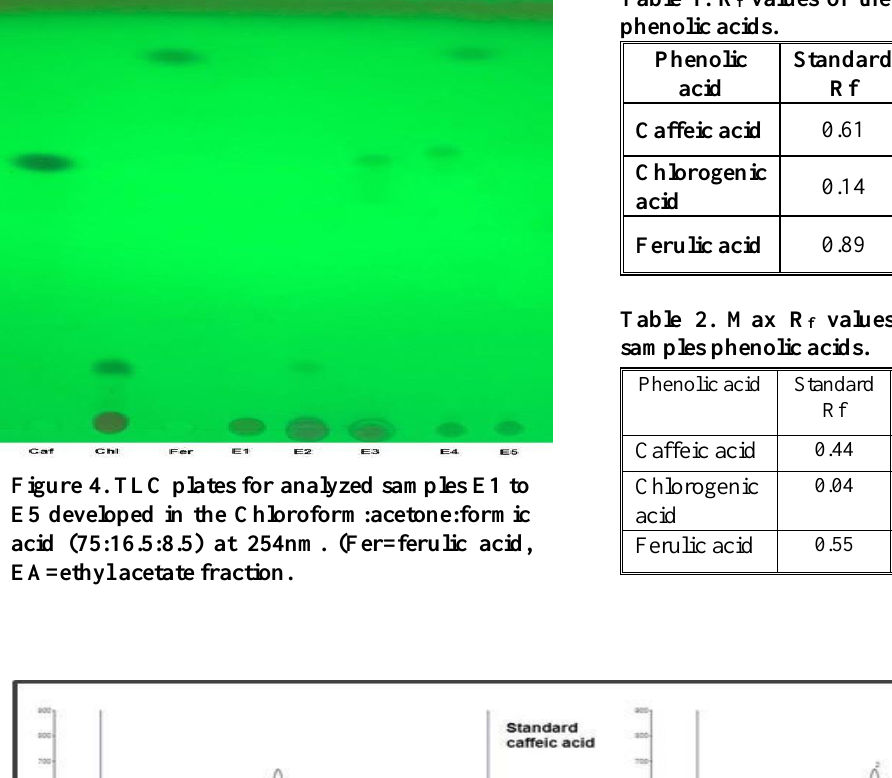
Table 1. R f values of the standard and samples